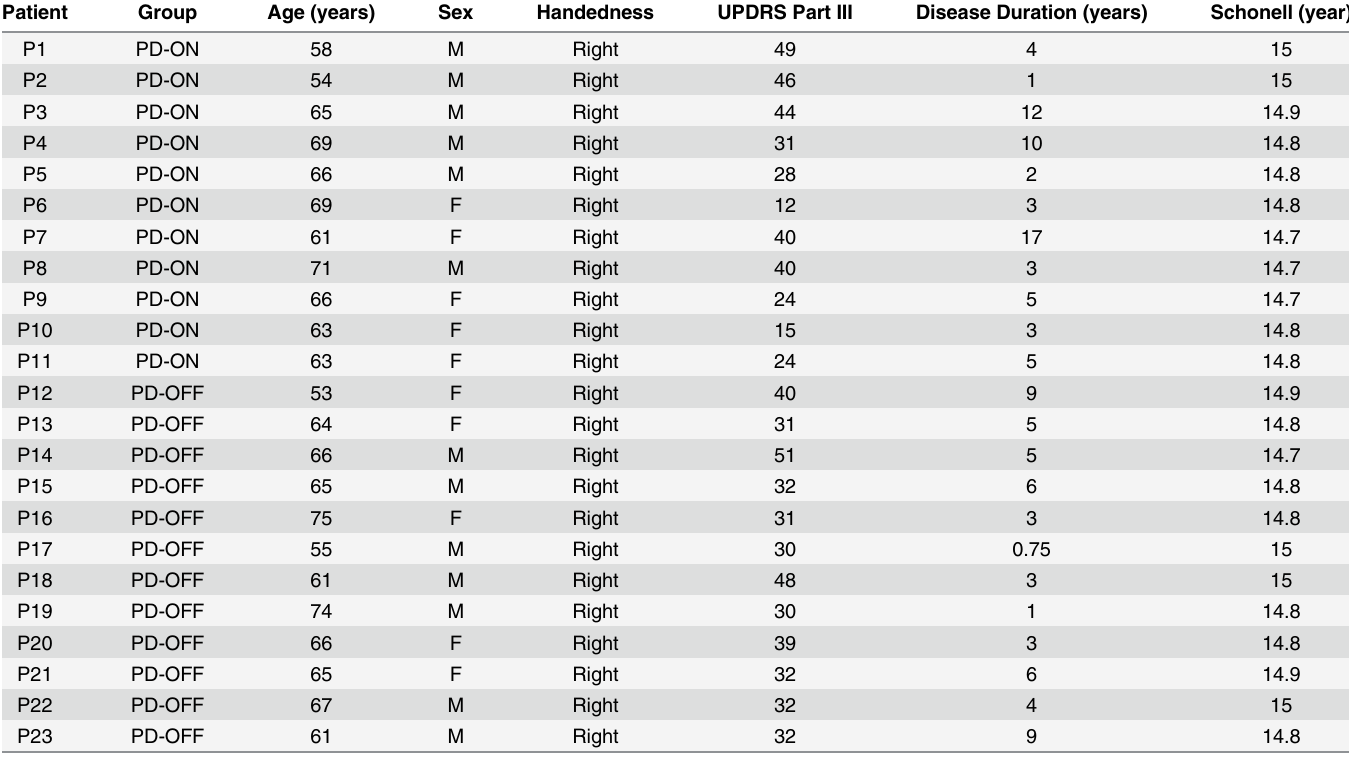
Table 1. Characteristics of the people with Parkinson ’ s disease.